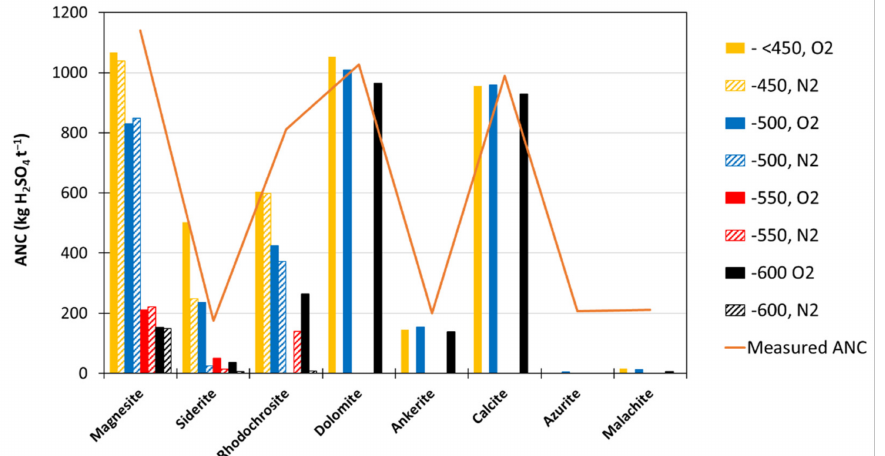
Figure 3. Comparison of ANC derived from thermal decomposition data (ANC thermal-carb ) and titration (ANC titrate-all ). The numbers in the legend refer to the temperature below which the CO 2 emission was considered to be associated with non-neutralising carbonate phases. Note: The ‘<450, O 2 ’ data are derived from the 400 ◦ C, O 2 carrier gas values for dolomite, ankerite, calcite, azurite and malachite.